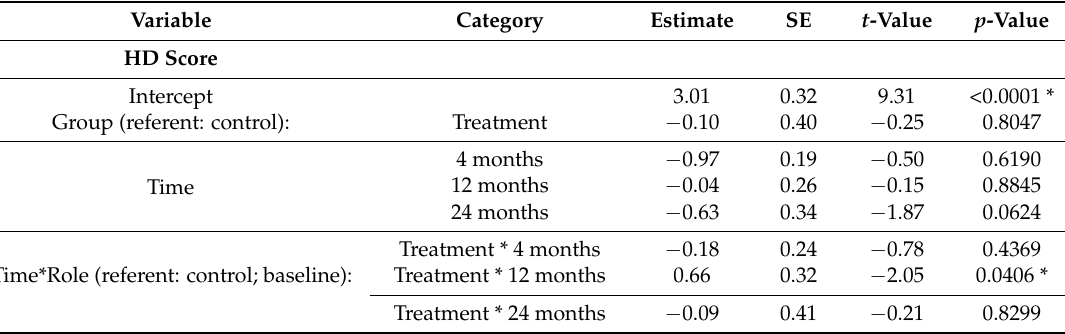
Table 3. Mixed Regression Models for HD